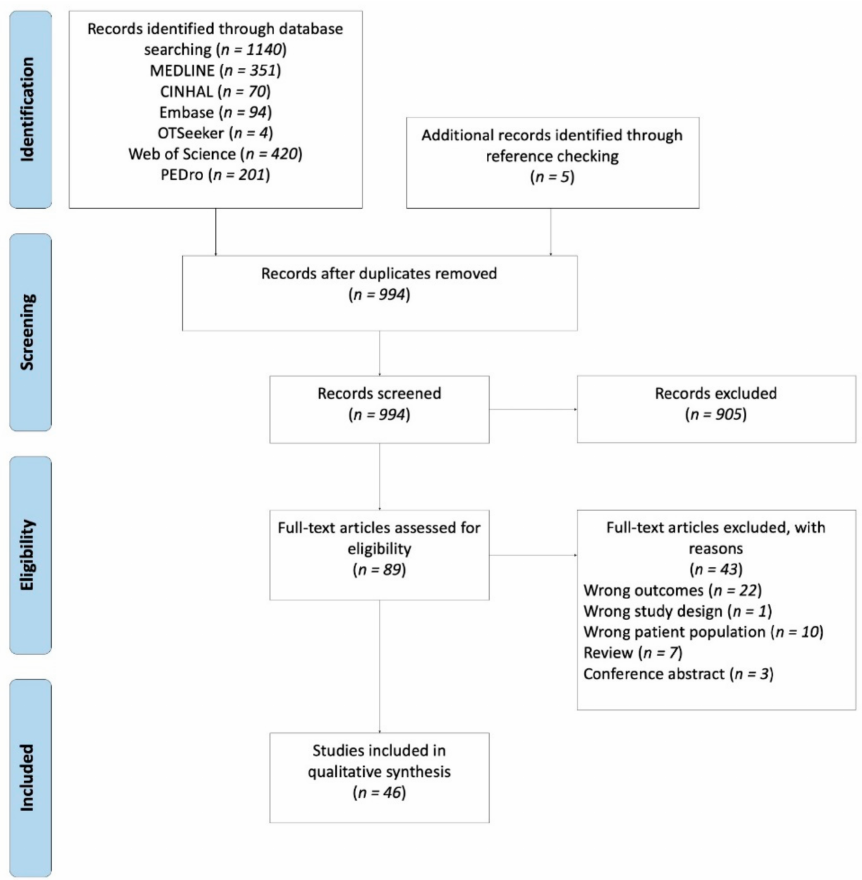
Figure 2. Selection process Prisma Flow